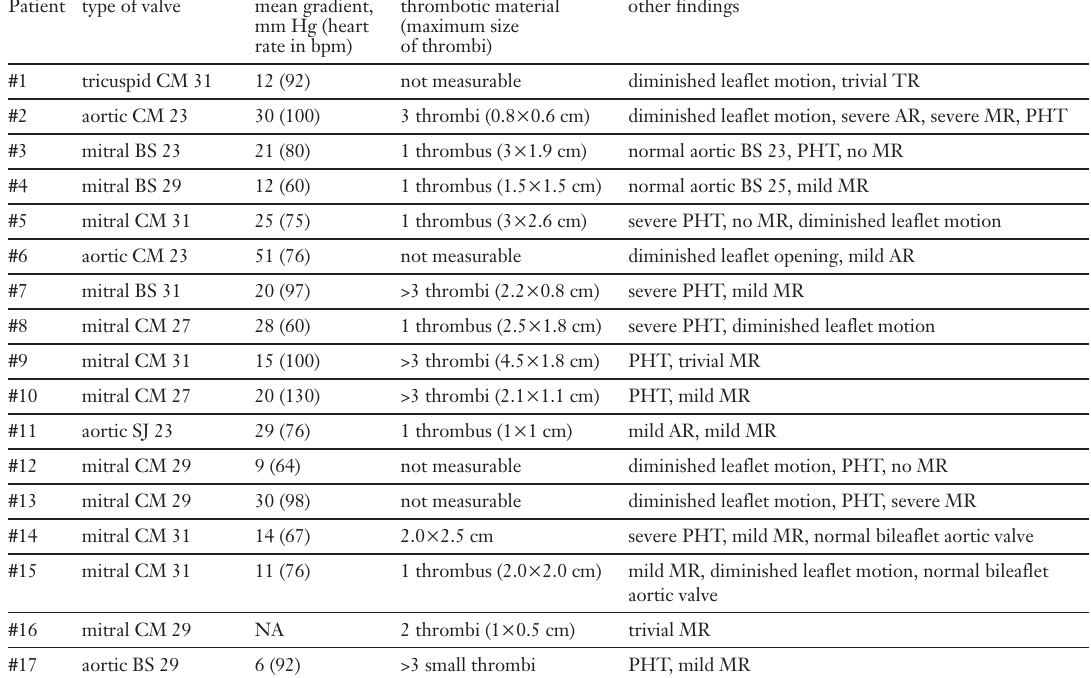
Left atrial size was increased in 15 patients (88%), with a giant left atrium (end-systolic diam- eter ≥ 6.0 cm) in 8 (47%). Left ventricular function